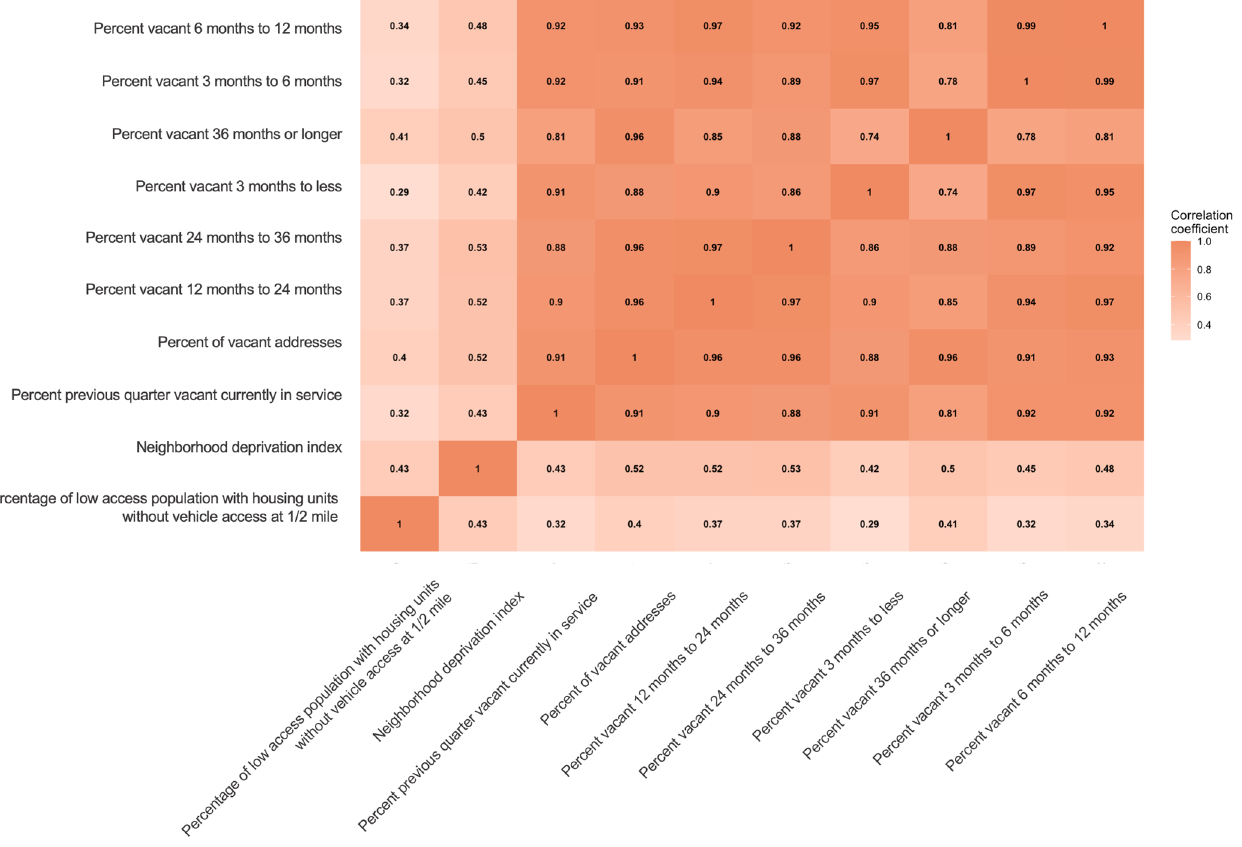
Figure A1. Correlation heatmap of significant SDoH variables from Phase 1 of the two-phase ap- proach.